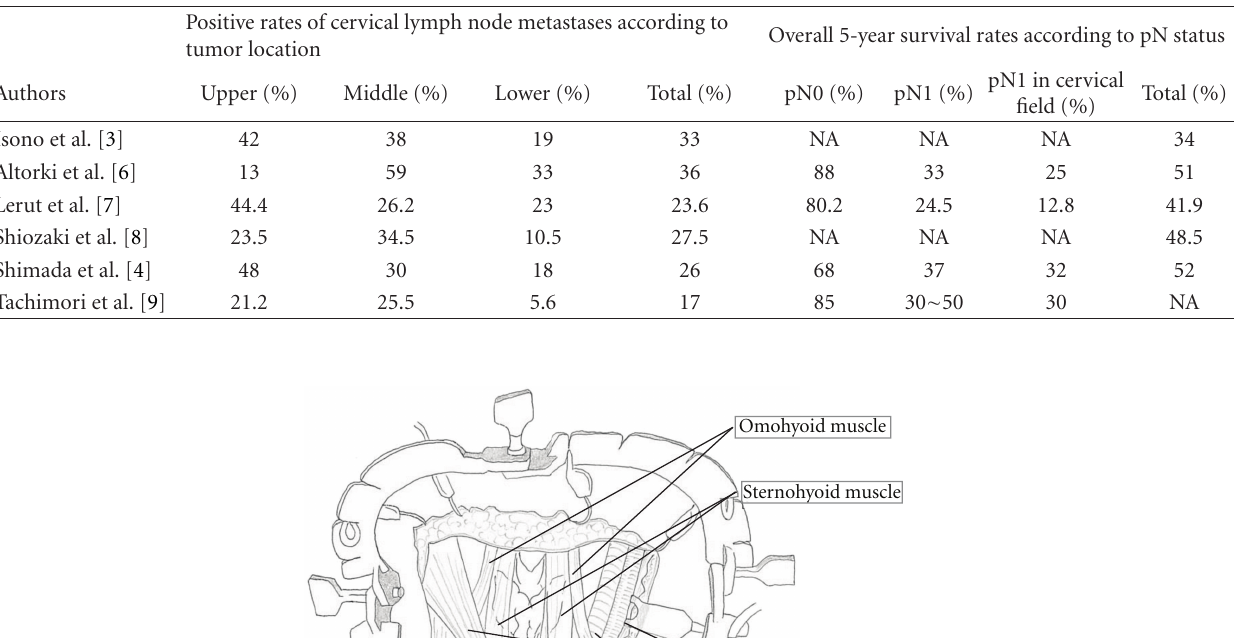
Table 1: Positive rates of cervical lymph node metastases and overall five-year survival rates after three-field lymph node dissection.